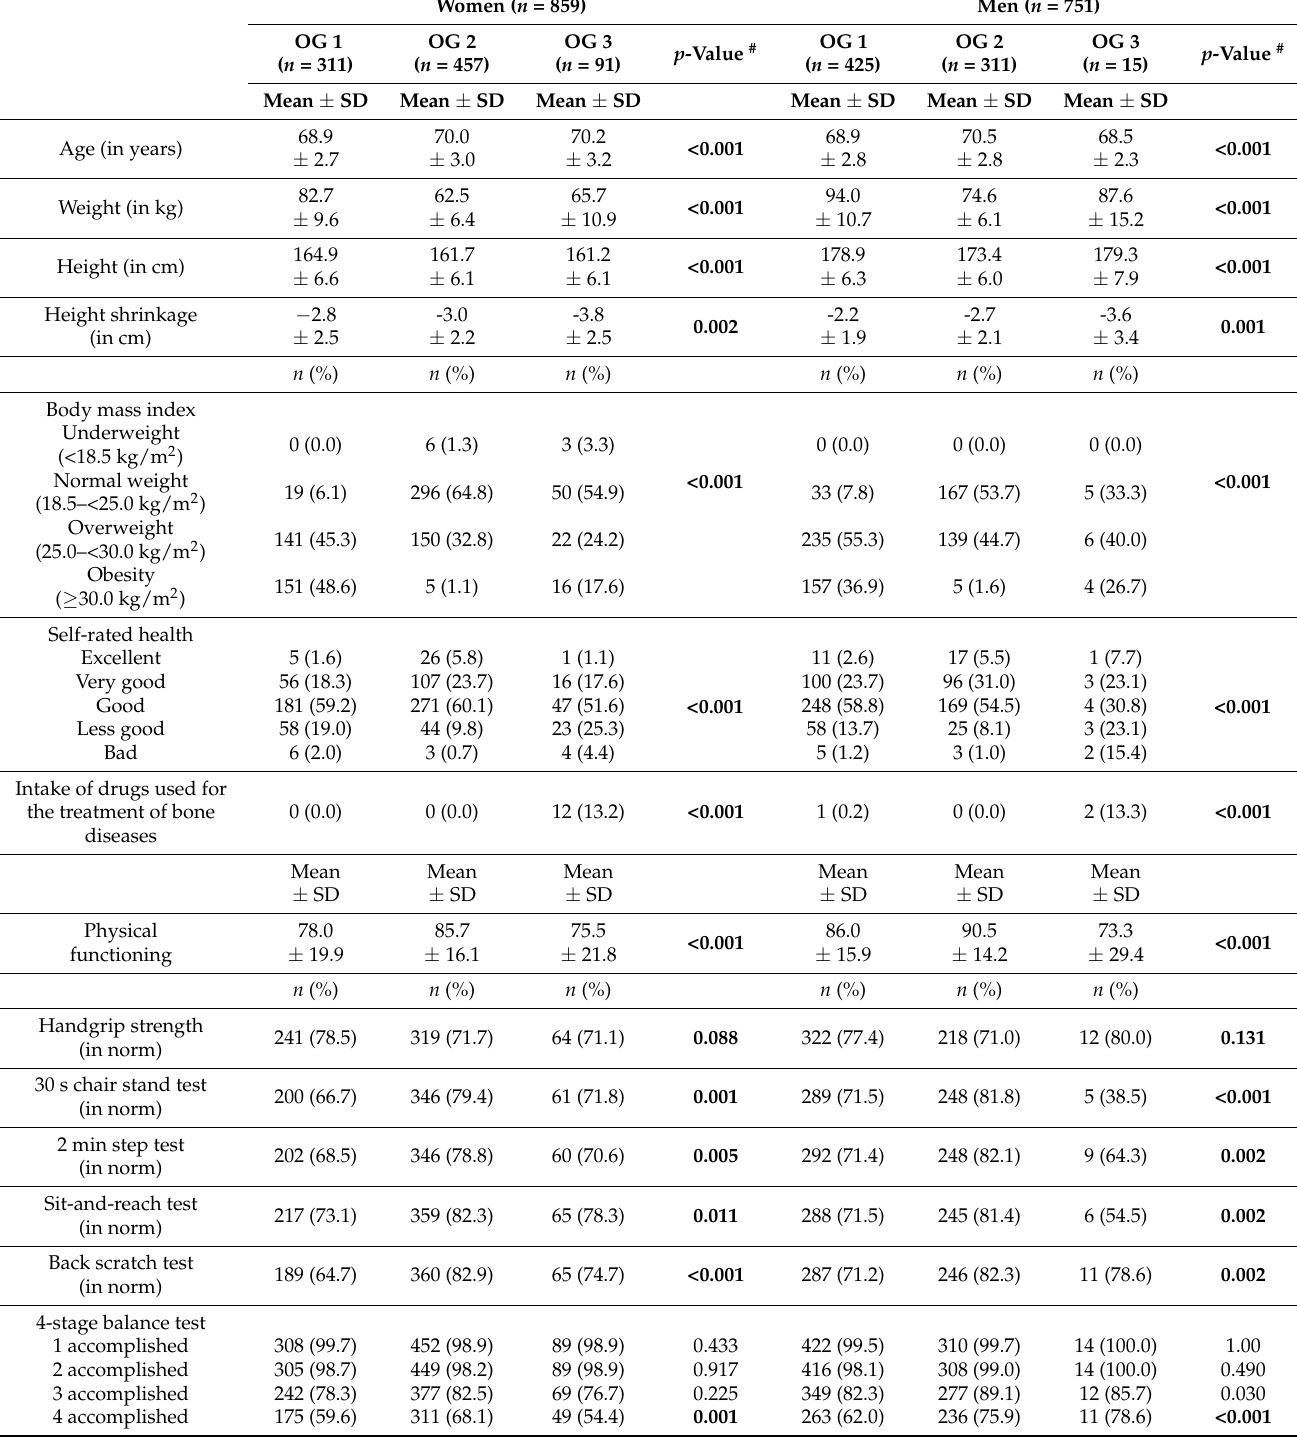
Table 4. Health and physical fitness of participants by sex and osteoporosis